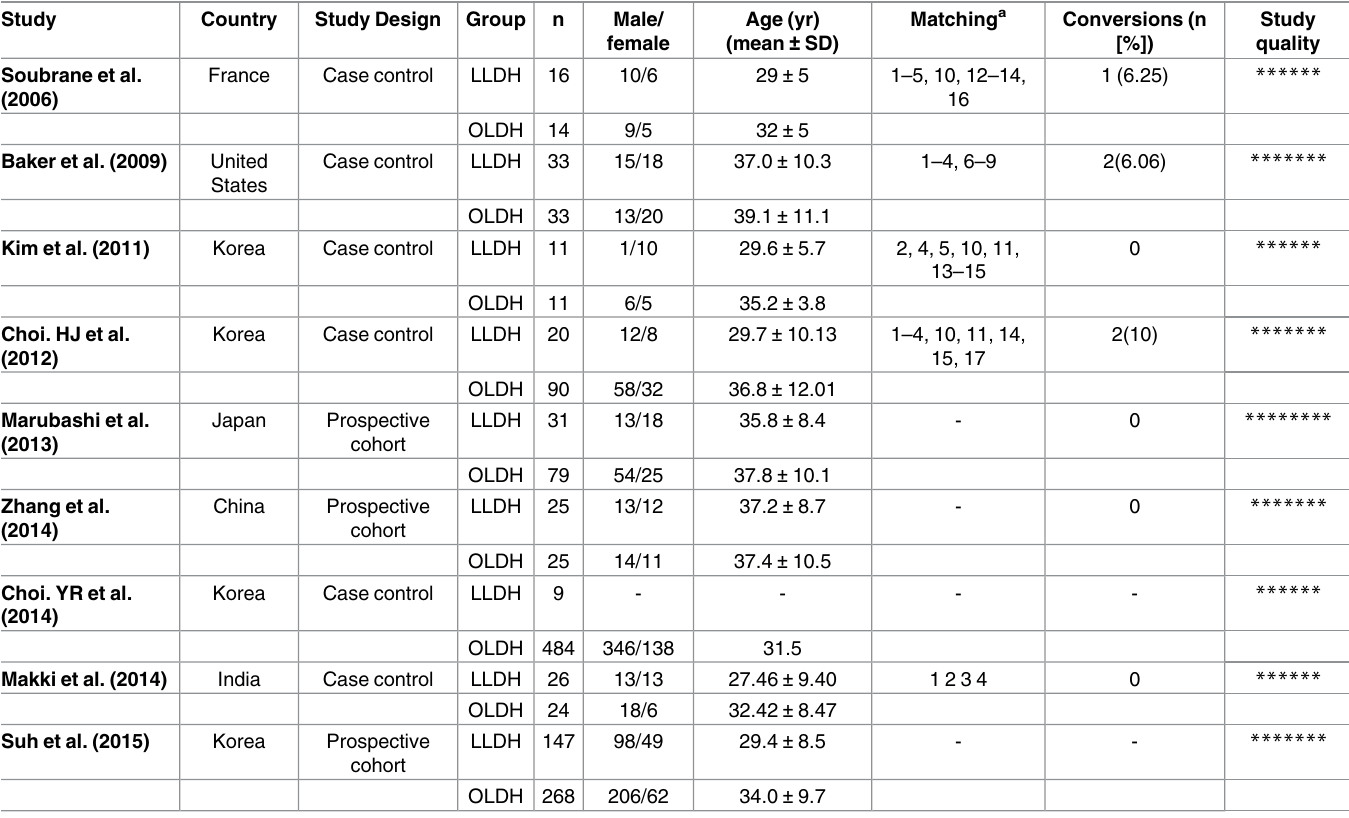
Table 1. Characteristics of studies included in the meta-analysis.